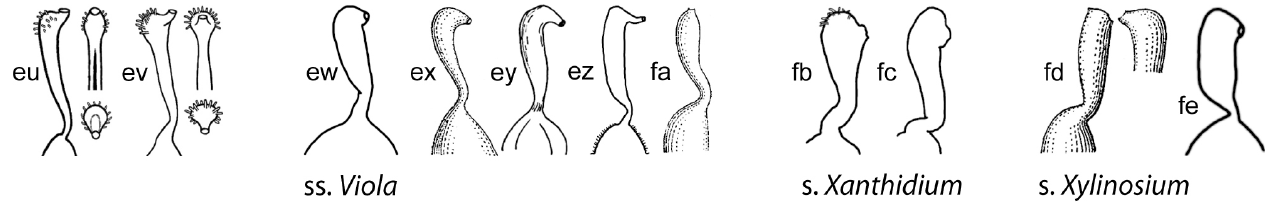
Figure 9. Style shapes in Viola . ( a – ae ) Subg. Neoandinium . ( af – fe ) Subg. Viola .— Sect. Confertae : ( a )